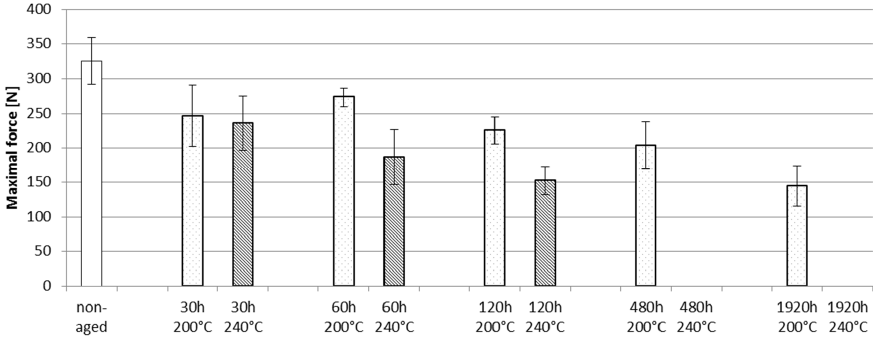
Figure 15. Shear testing results for Rogers samples.